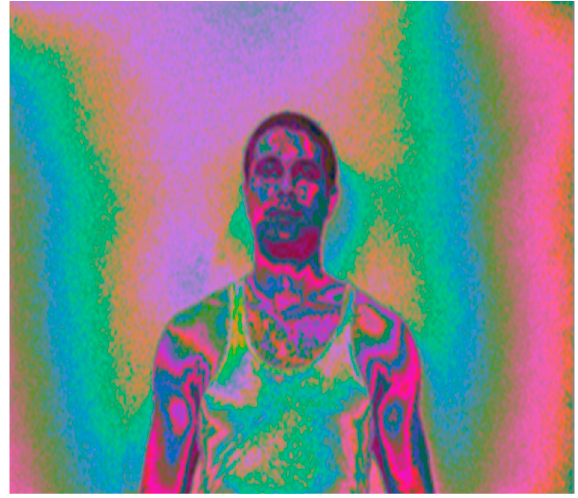
Figure 15. Aura visualization before the therapy.